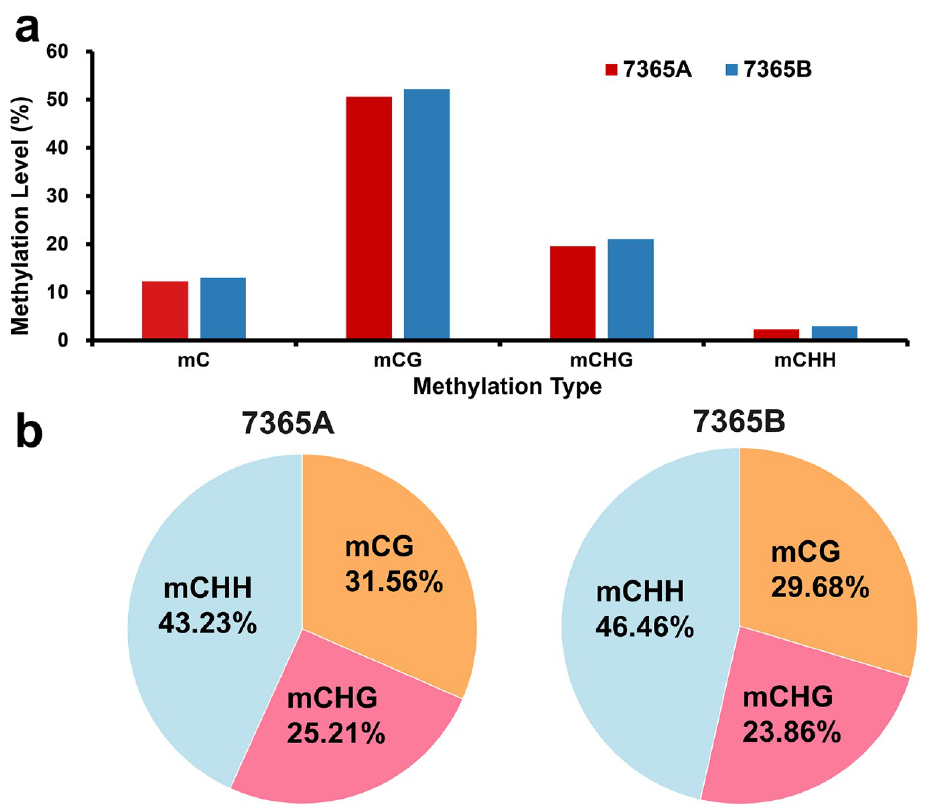
Figure 2. Genome-wide DNA methylation patterns of 7365A and 7365B. ( a ) Average methylation levels of CG, CHG and CHH in the whole genome; ( b ) Percentages of methylated cytosines under each